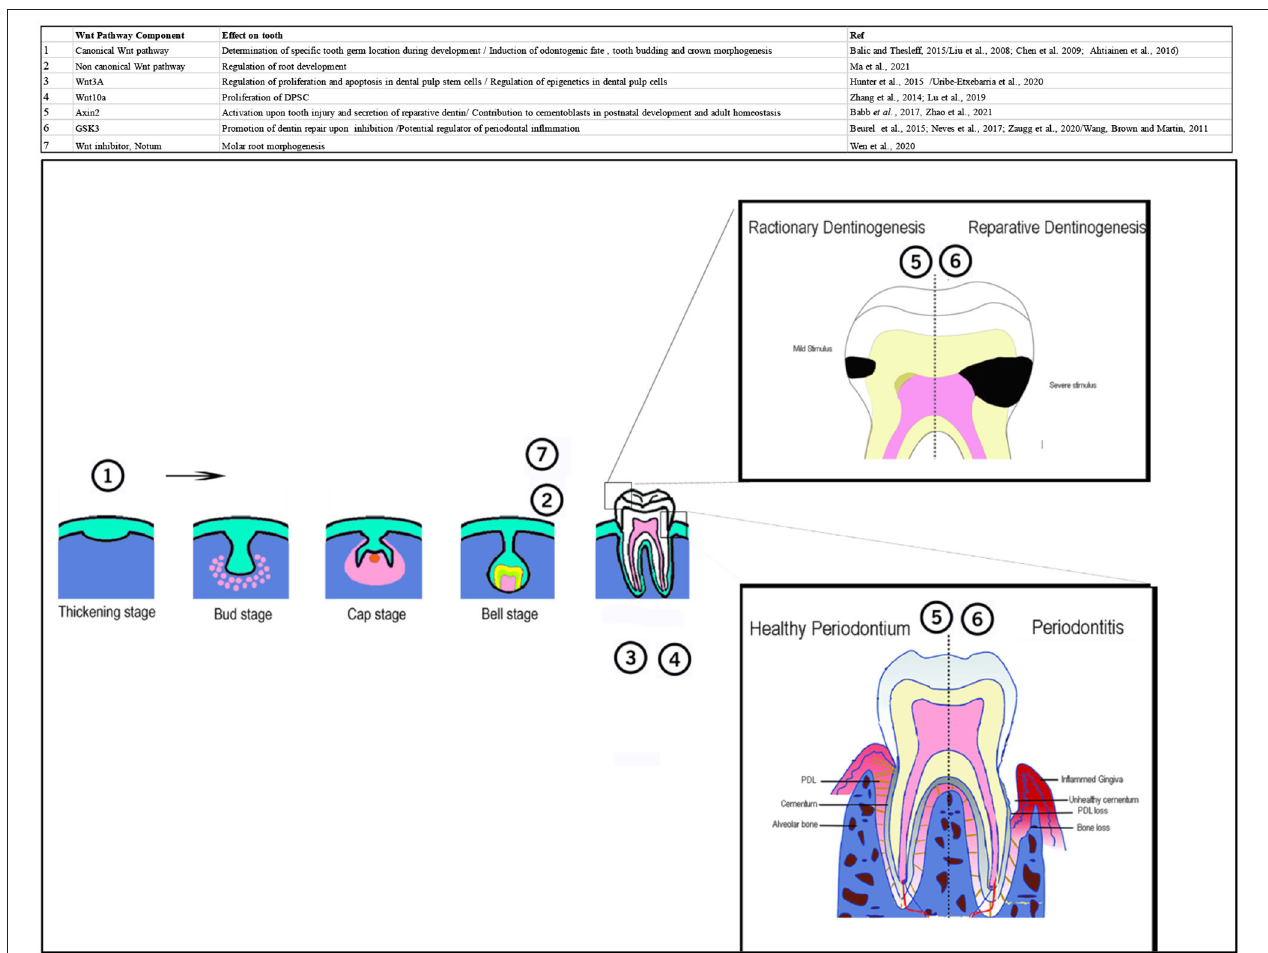
FIGURE 2 | Table and schematic, summarising different roles of Wnt pathway during development, homeostasis, and regeneration of tooth and periodontium. Numbers in the schematic corresponds to the number of pathway component in the table. 1: canonical Wnt pathway is involved in determination of specific tooth germ location during development and induction of odontogenic fate, tooth budding and crown morphogenesis. 2: Noncanonical Wnt pathway regulates root development. 3: Wnt3A regulates proliferation and apoptosis in dental pulp stem cells. It is also involved in the epigenetic regulation of DPSCs. 4: Wnt10 regulates proliferation of DPSCs. 5: Axin2 + cells are activated upon tooth injury and induce secretion of reparative dentin. In the periodontium these cells contribute to cementoblasts formation during postnatal development and adult homeostasis. 6; Inhibition of GSK3 promotes dentin repair. It is a potential regulator of periodontal inflammation. 7: Notum, Wnt inhibitor is involved in molar root morphogenesis. A part of this schematic was adapted from Xu et al. (79).